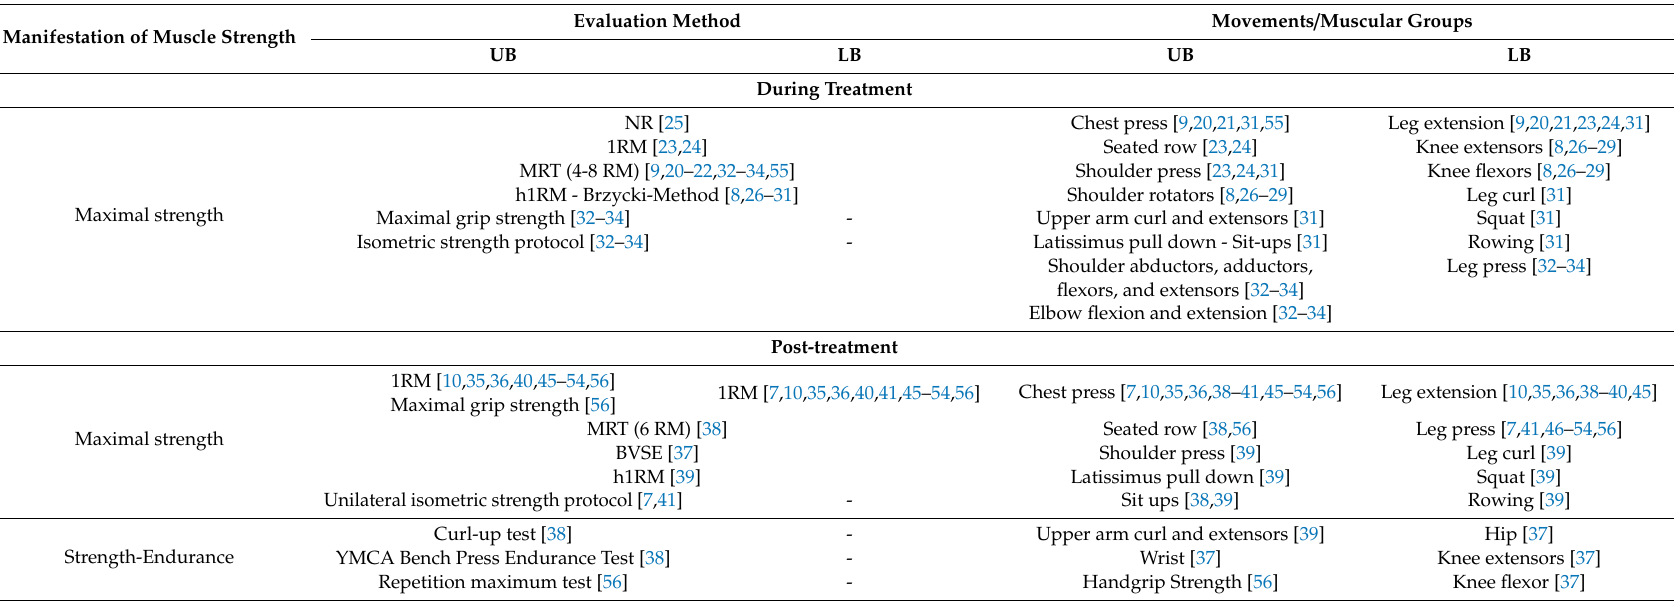
Table 7. Manifestations, methods and muscular groups